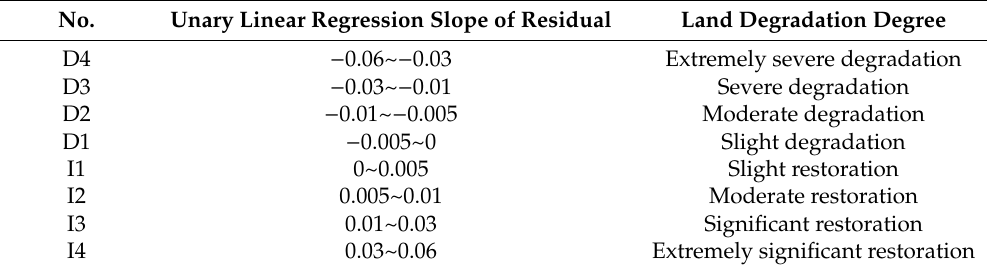
Table 1. Residual Change Trend